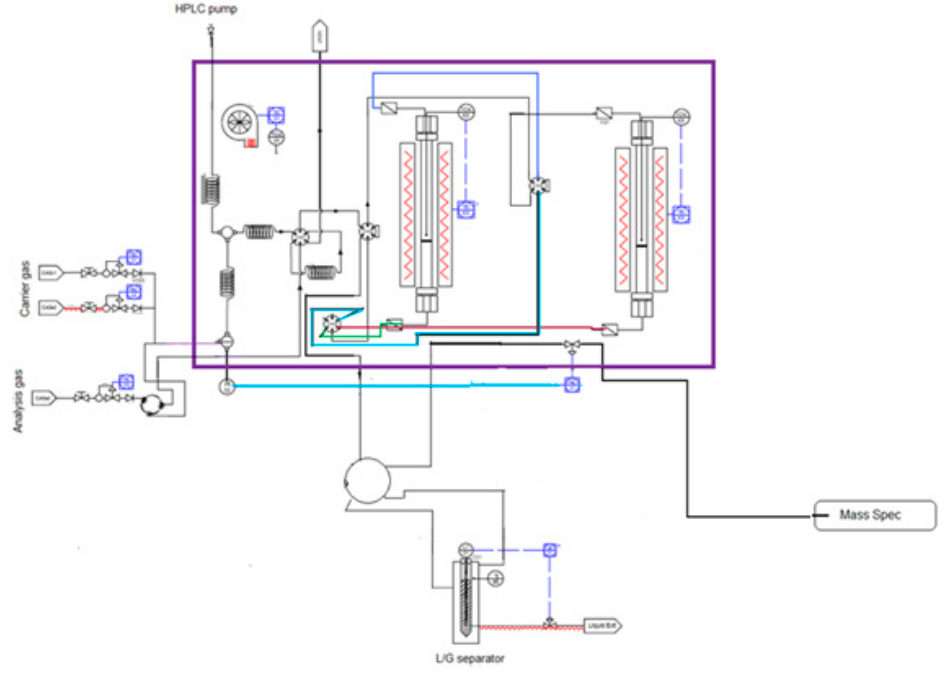
Figure 1. Flow-diagram of the Micro Catalyst Characterization and Testing Center (MCCTC) to a mass connected to a mass spectrometer.